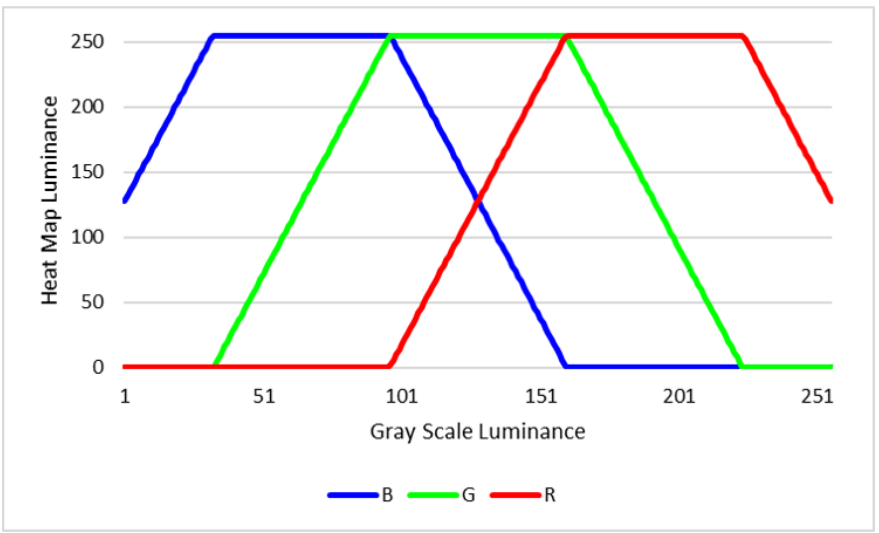
Figure 7. Heat map luminance towards gray scale luminance.